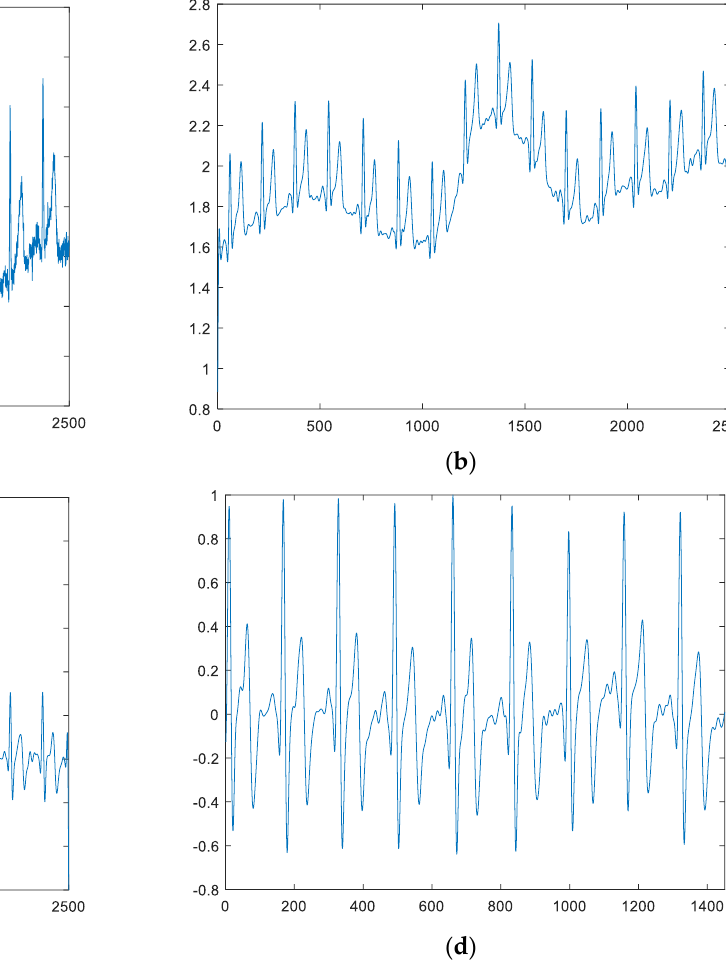
Figure 16. ECG through preprocessing. ( a ) Original signal; ( b ) Filtering; ( c ) Adjusting the baseline; ( d ) Standardization.